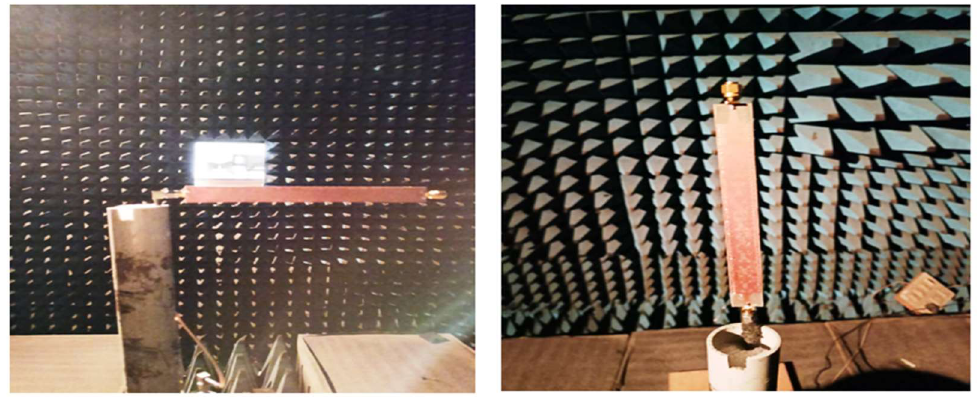
Figure 8. SIW LWA measurement setup for far field radiation patterns.